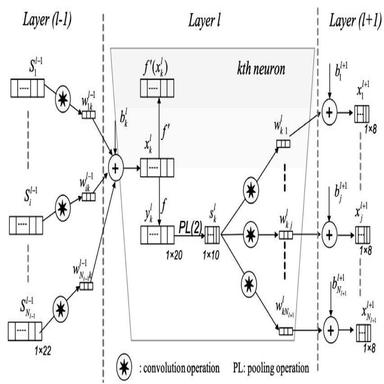
Illustration of three consecutive layers in a novel CNN model.